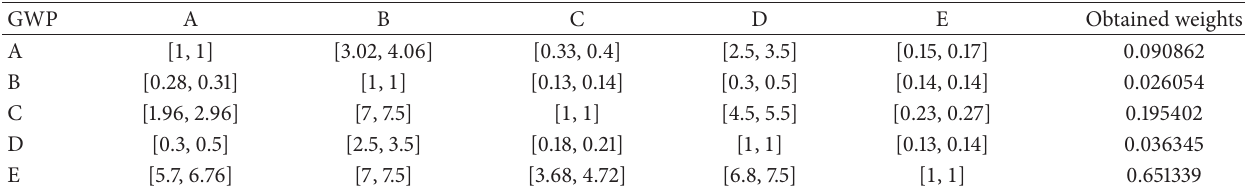
Table 13: The interval approximation purposed choices referring to GWP subcriteria.